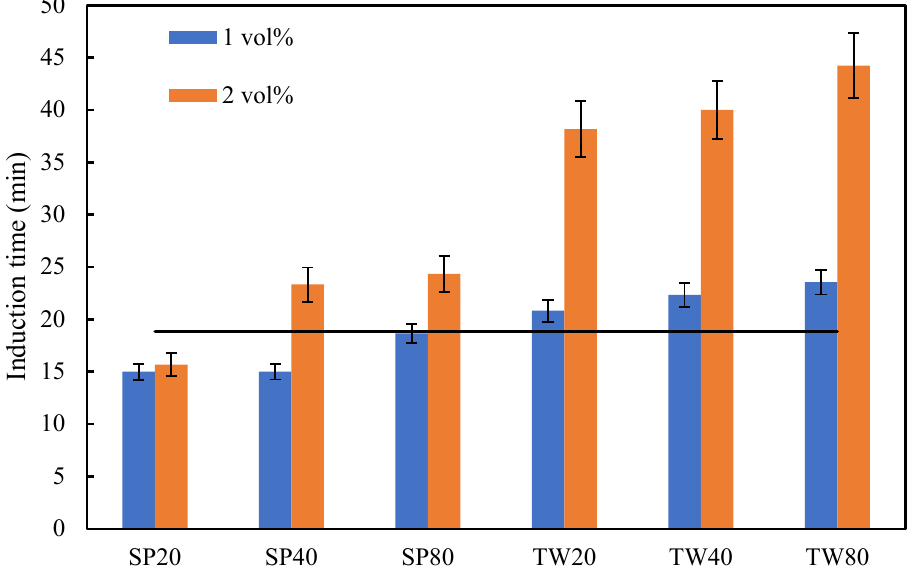
Figure 5. The induction time measurements of six non-ionic surfactants at 1.0% ( v / v ) and 2.0% ( v / v ) (Oil/H 2 O: 50/50; 277 K, 8.50 MPa).